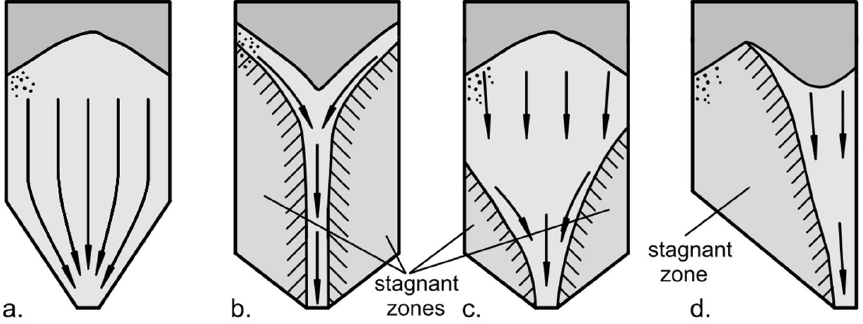
Figure 6. Flow profiles: ( a ) mass flow; ( b ) funnel flow (pipe flow); ( c ) funnel flow (mixed flow); ( d ) funnel flow (eccentric pipe flow). Source: [102]